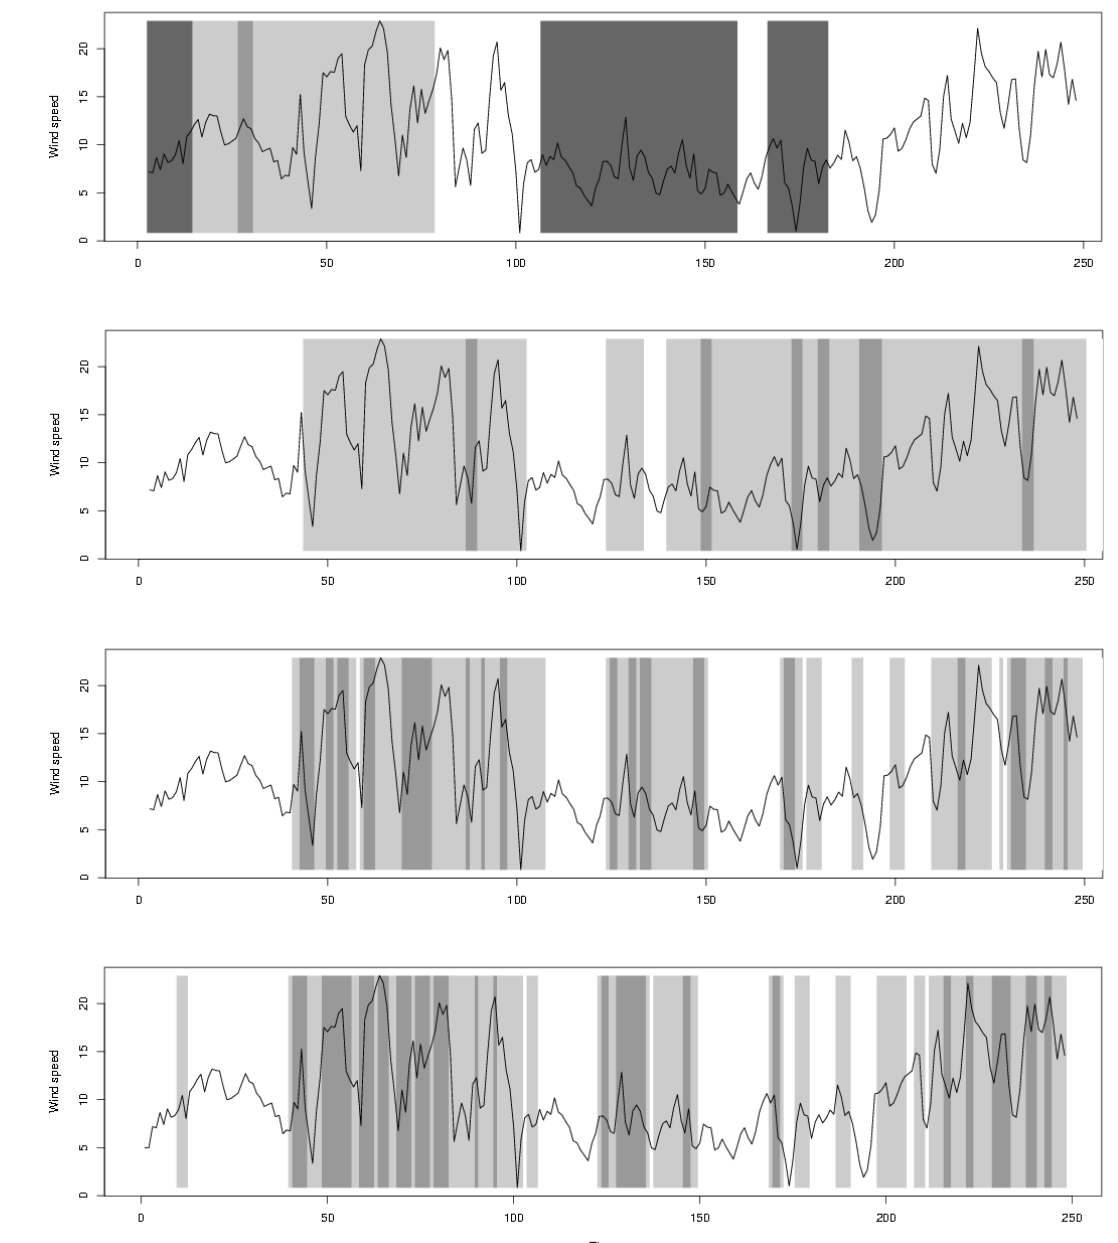
Figure 5. Time series of wind speed in January 2012 and a priori regimes extracted from the proposed methods above. The darker is the grey; the smaller is the determinant of (cid:54) ( i ) . From top to bottom: C Z 500 , C EOF( u,v ) , C Diff( u,v ) , and regimes from the fitting of the H-MS-VAR